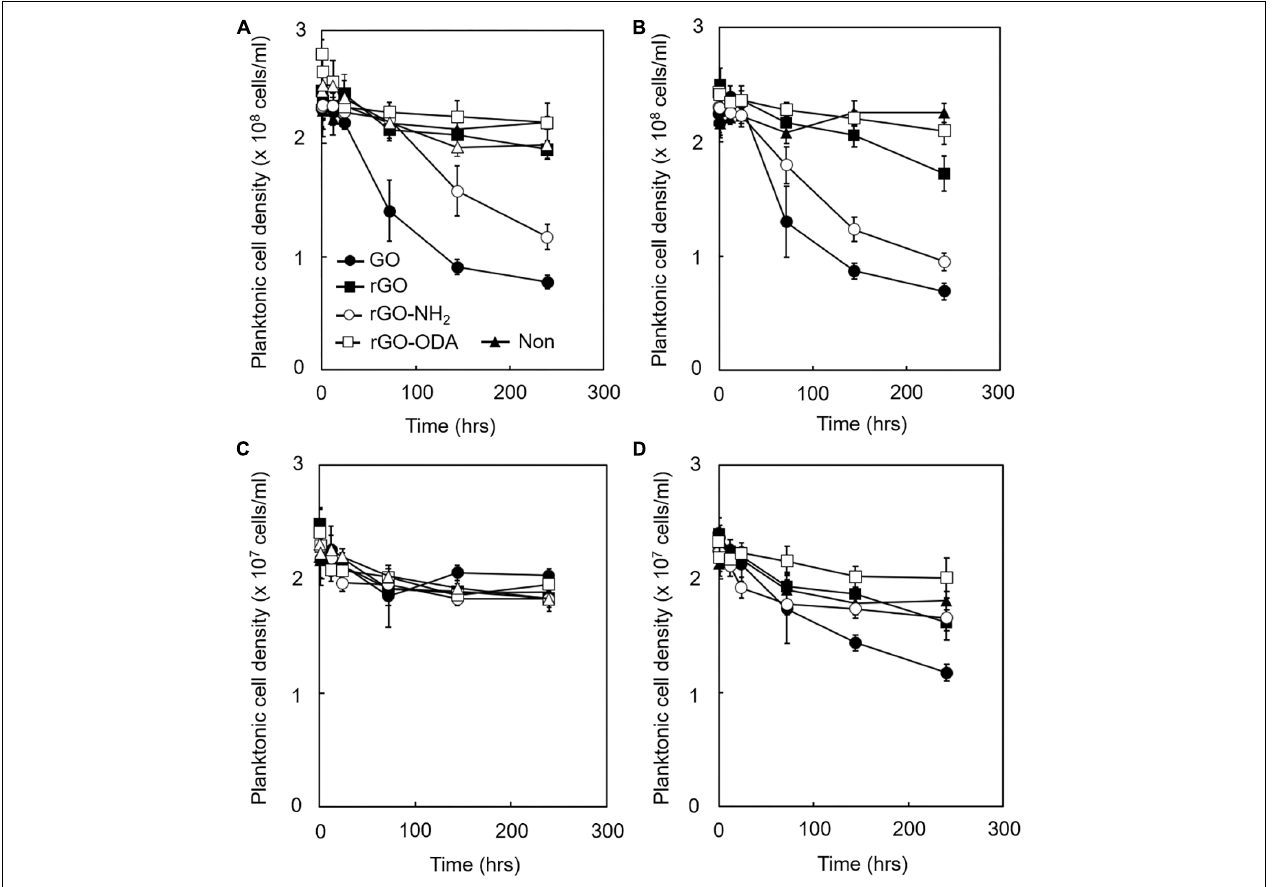
FIGURE 6 | Adhesion efficiency of microbial cells to GO-based materials. Each GO-based material was supplemented with IET-P medium containing ethanol (20 mM). The planktonic cell density of G. metallireducens (A,B) and M. barkeri (C,D) is shown. Monoculture (A,C) . Coculture (B,D) . Cultivations were conducted under the same cultivation conditions as described in section “Microorganisms and Cultivations,” except the initial cell density of G. metallireducens and M. barkeri was set to 2.5 × 10 8 cells/mL and 2.5 × 10 7 cells/mL, respectively. Data are presented as the means of three independent cultures, and error bars represent standard